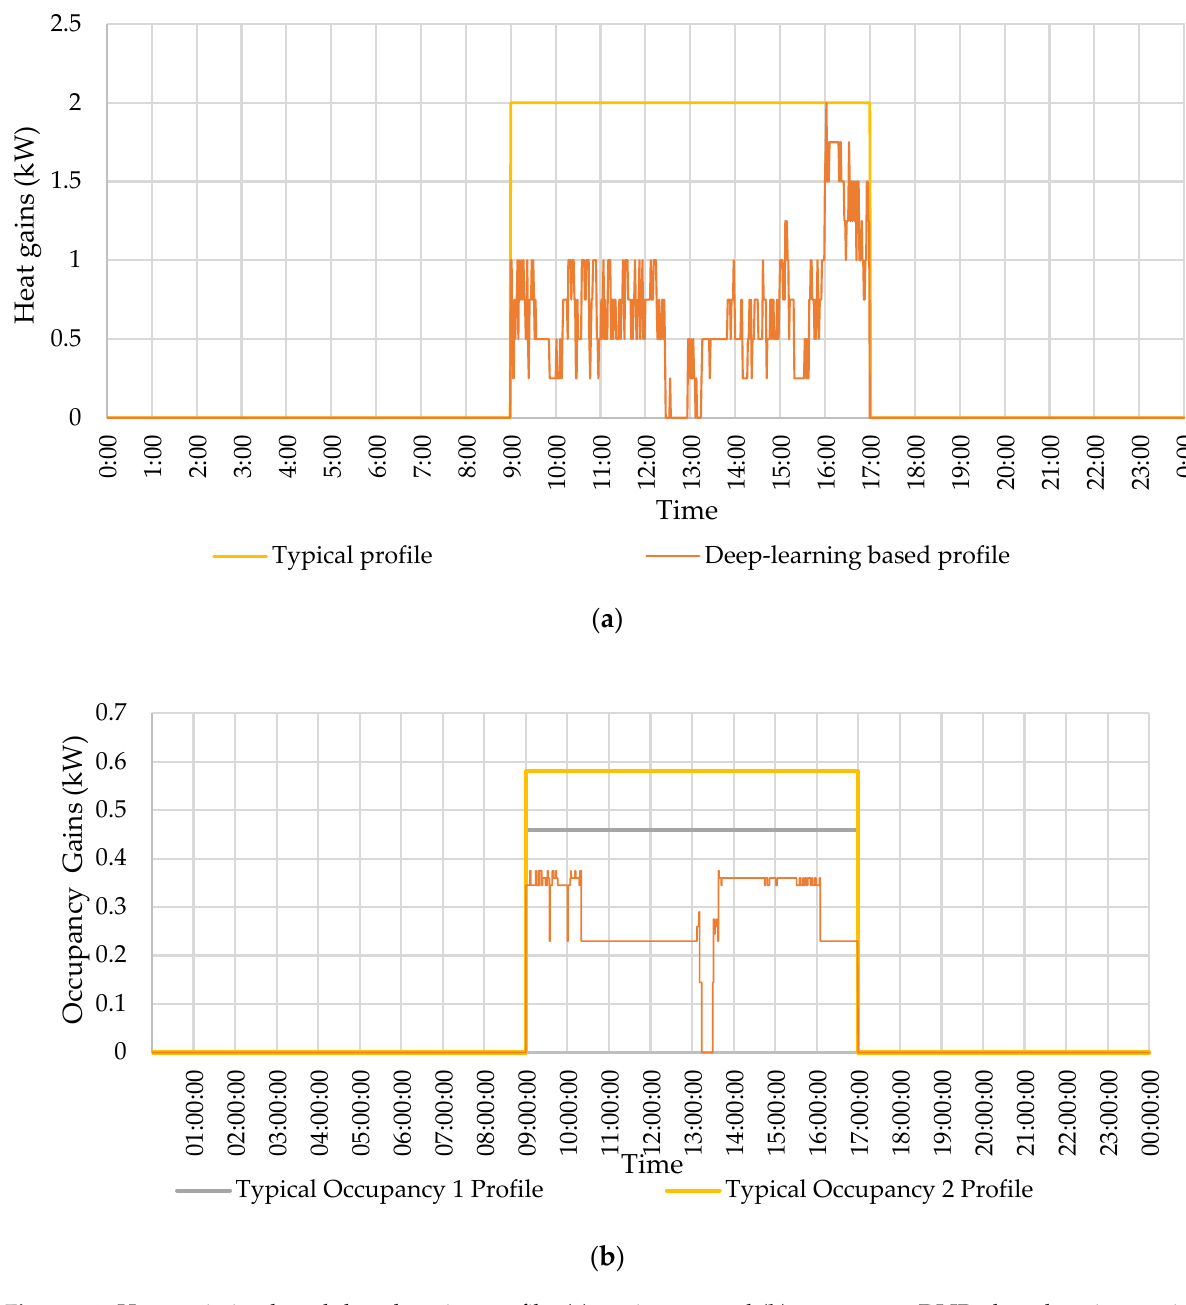
Figure 14. Heat-emission-based deep learning profile, ( a ) equipment and ( b ) occupancy. DLIP plotted against typical profiles from (Figure 8) for